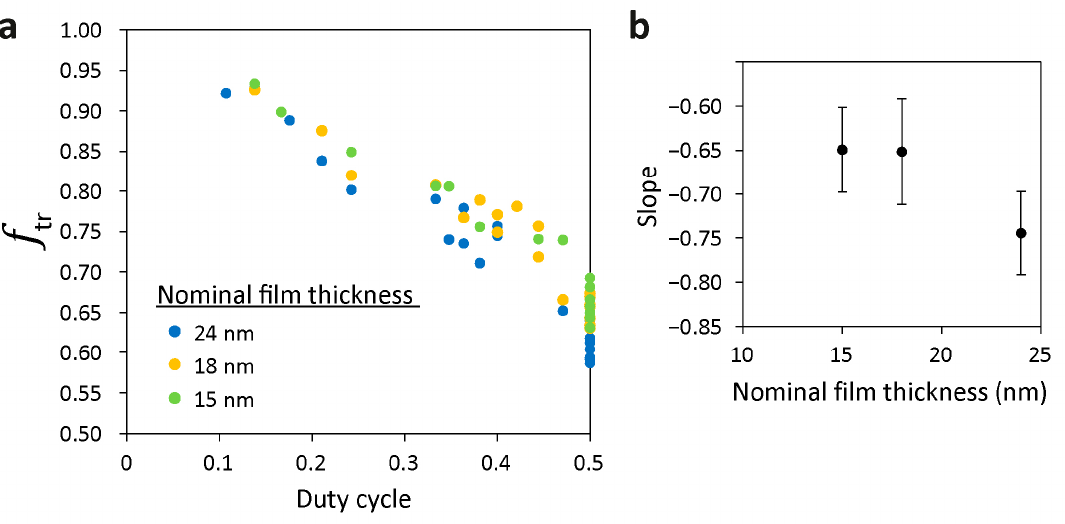
Figure 6. ( a ) Dependence of the fraction of BCP in the trench on the duty cycle (see supplementary Figure S3 for the individual curves). ( b ) Dependence of the slopes of the data in ( a ) on nominal film thickness for a constant trench depth of 38 nm.